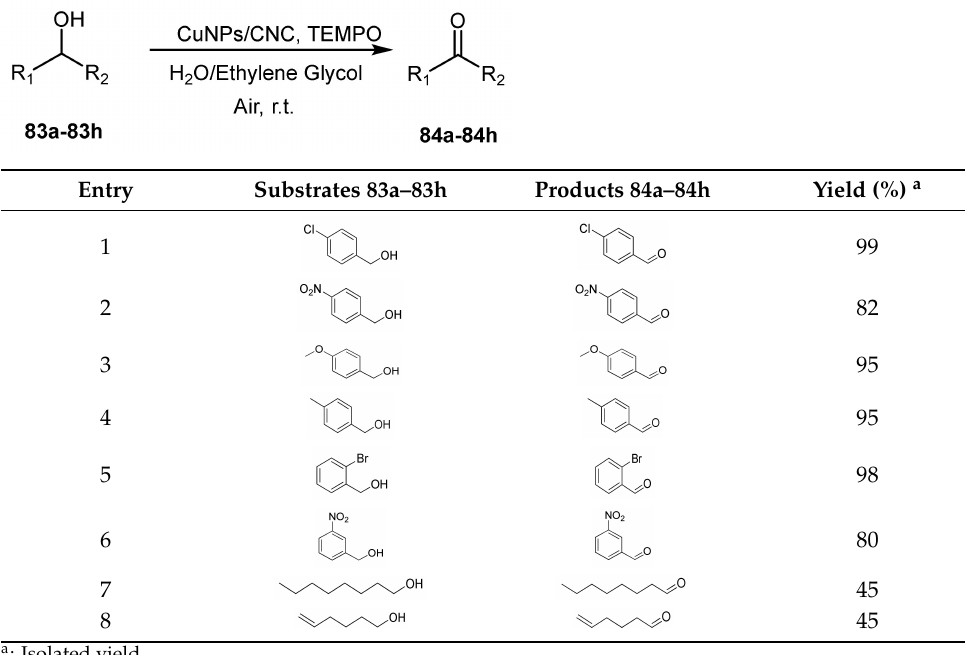
Table 8. Oxidation on different alcohols by CuNPs/NC and